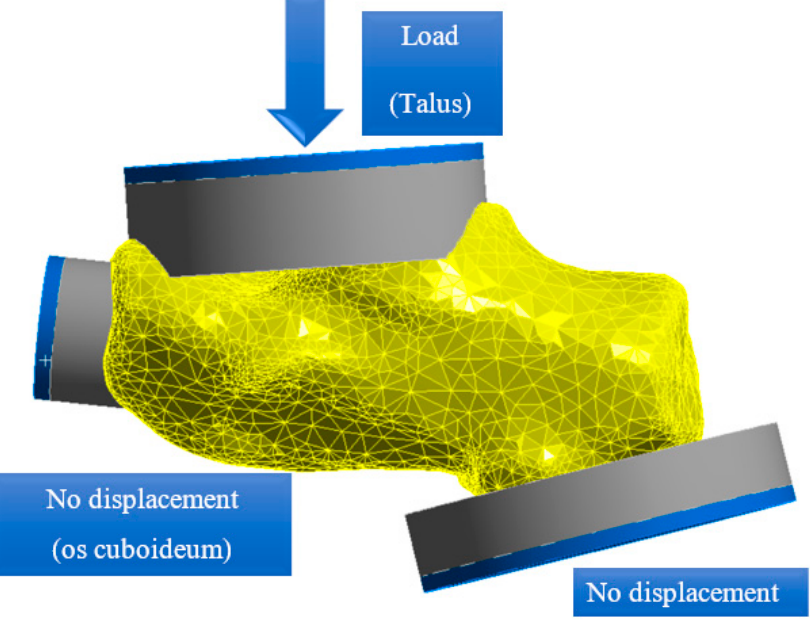
Figure 11. Boundary conditions.